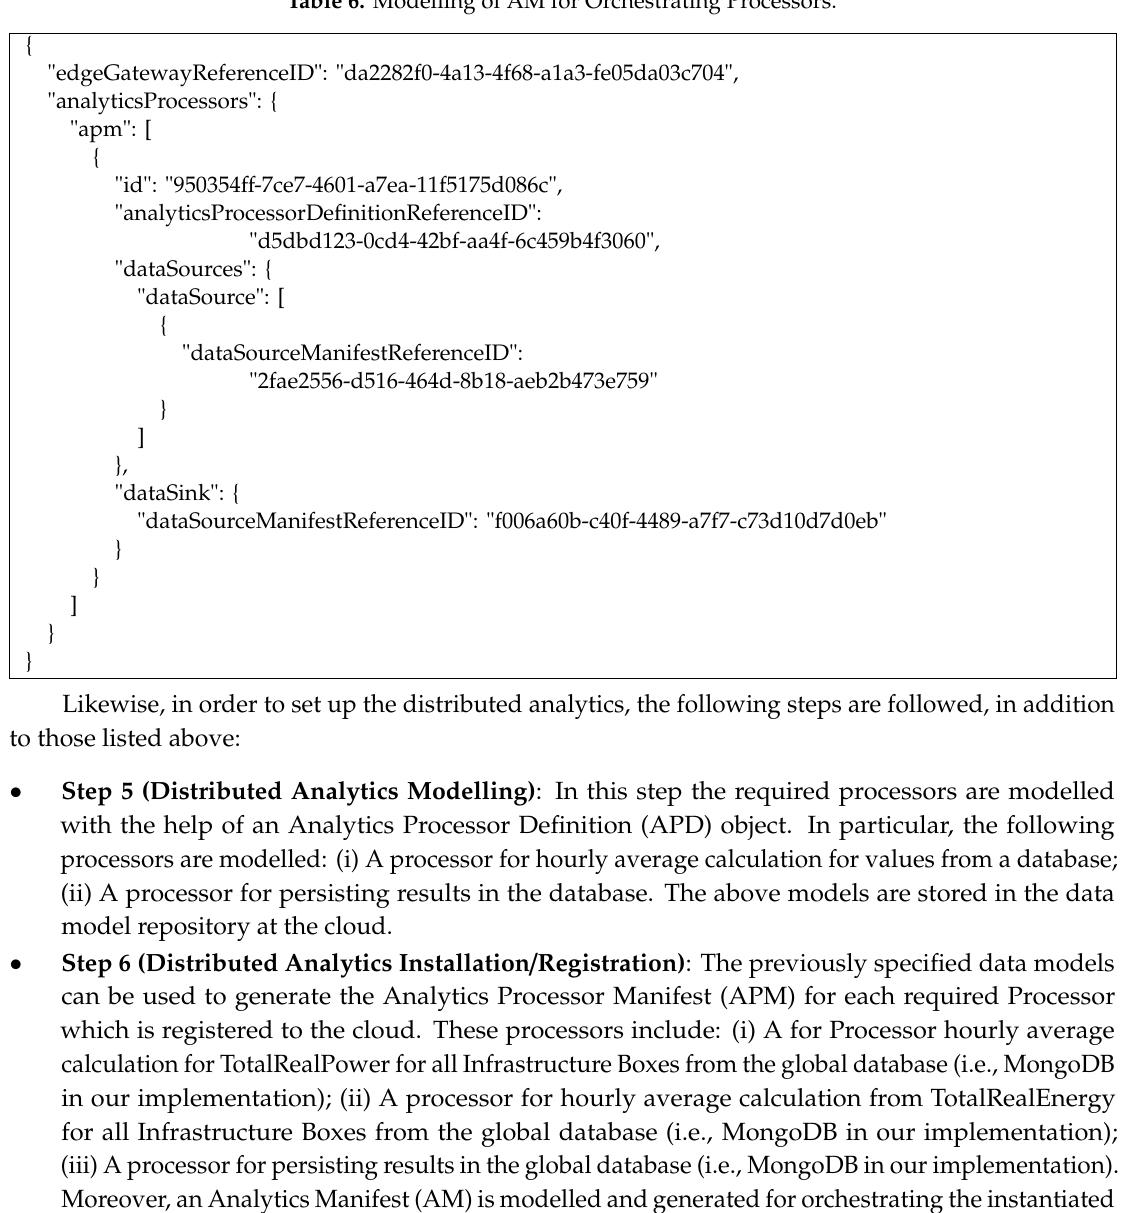
Table 6. Modelling of AM for Orchestrating